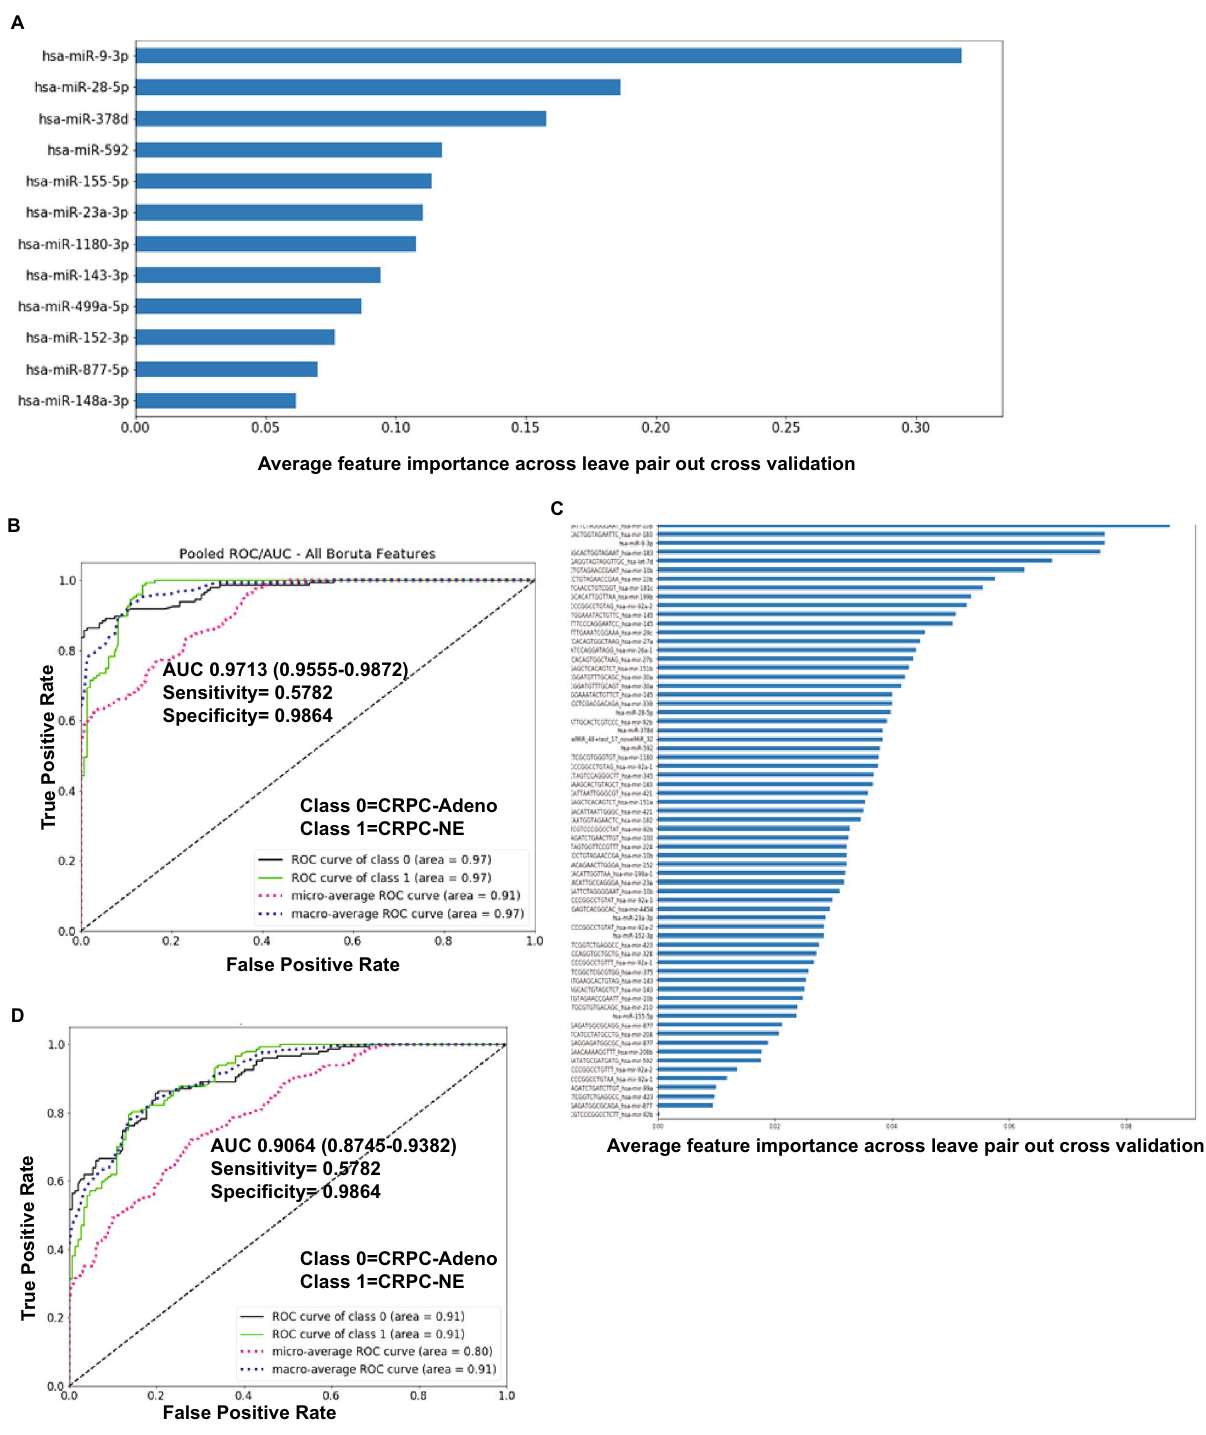
Figure 3. An EV-microRNA classifier of neuroendocrine differentiation in castration resistant prostate cancer. ( A ) Application of machine learning methods (random forest machine learning technique with leave-pair- out cross validation) to the NGS dataset of analyzed NE tissues + NCI-H660 cell line (CRPC-NE, n = 7) vs those with adenocarcinoma features (CRPC-Adeno, n = 21) yielded a ‘12 miRNA classifier’. miRNAs are